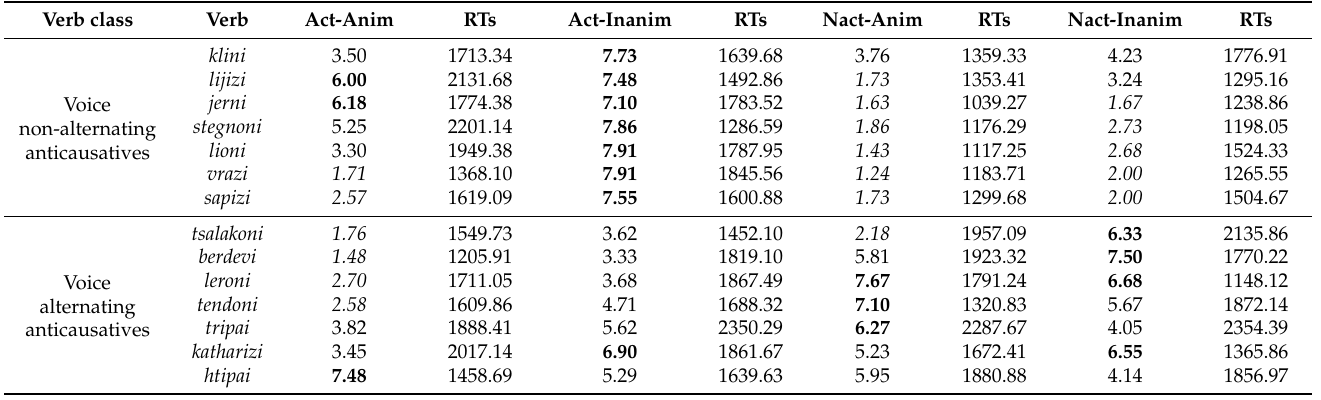
Figure 5. Violin plot: distribution of the degree of acceptability (by voice morphology, verb class). Deviant cases of low acceptability of ‘voice non-alternating’ anticausatives in ACT (92/602; 15.28%) and ‘voice alternating’ anticausative verbs in ACT (150/602; 24.92%) and NACT (90/602; 14.95%) come from specific verbs, animacy of the syntactic subject considered, and are to be examined in a per verb analysis (Table 4). Table 4. Individual verbs mean acceptability rates and RTs across the experimental conditions (voice, animacy).